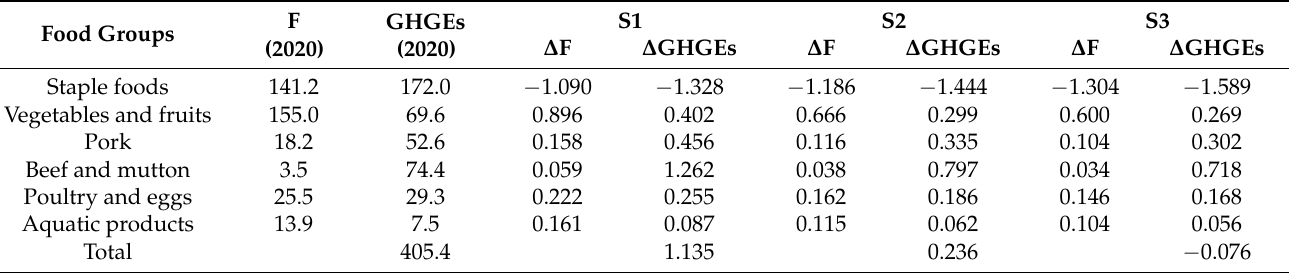
Table 6. The projected impacts of income growth on food demands and GHGEs